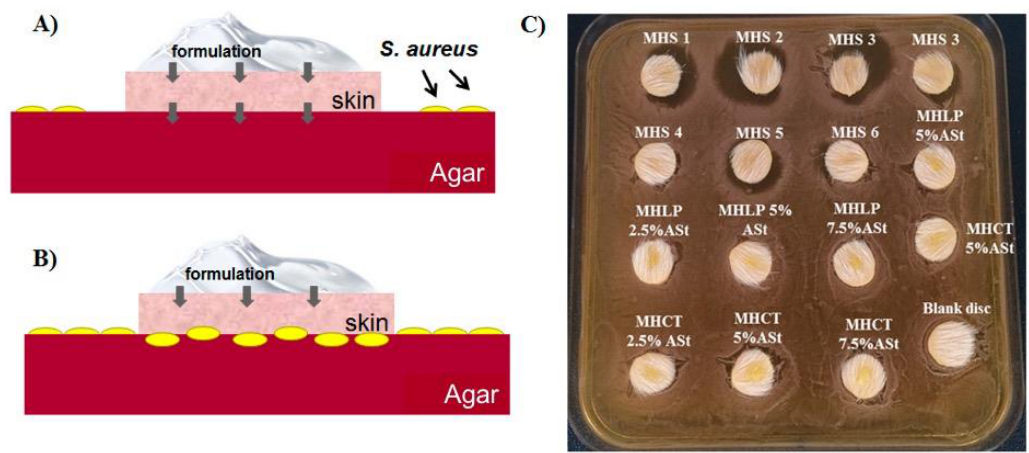
inhibits S. aureus growth and an inhibition zone is observed around the skin disk. ( B )—Drug skin